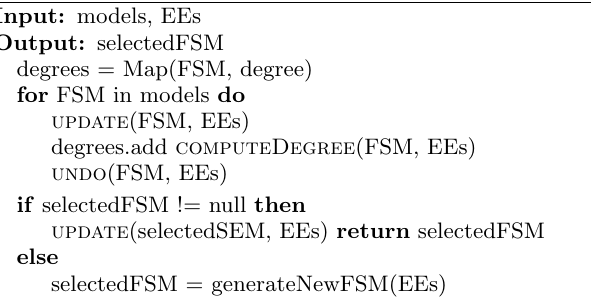
Algorithm 1 Finite State Machine